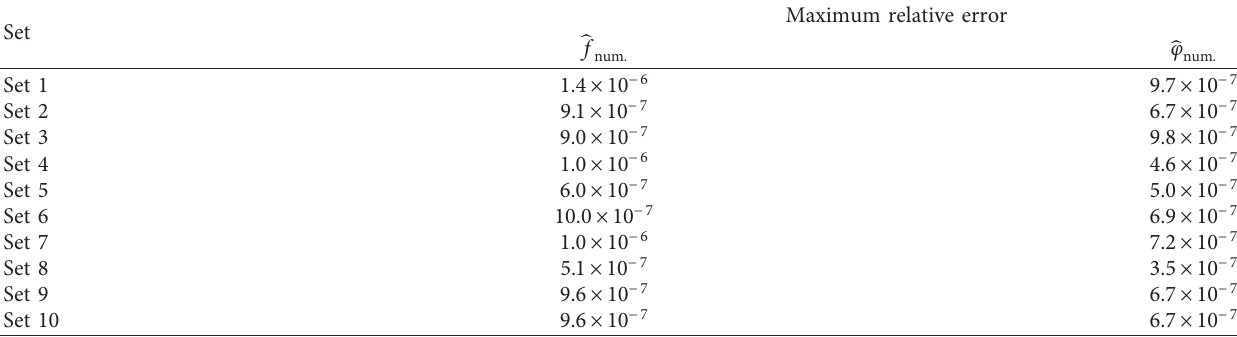
and 􏽢 φ with Δ τ � 0 . 005 and Δ v � 0 . num . num .